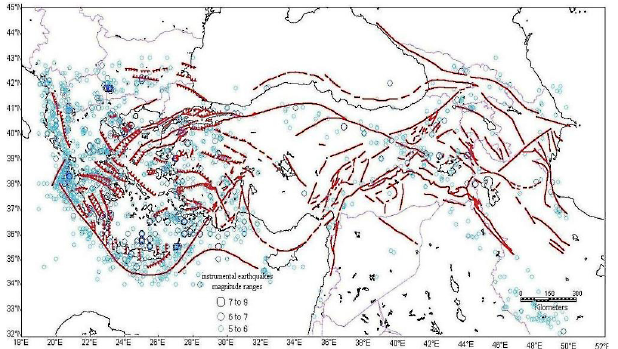
Fig. 1. Tectonic Features (from McKenzie, 1972).